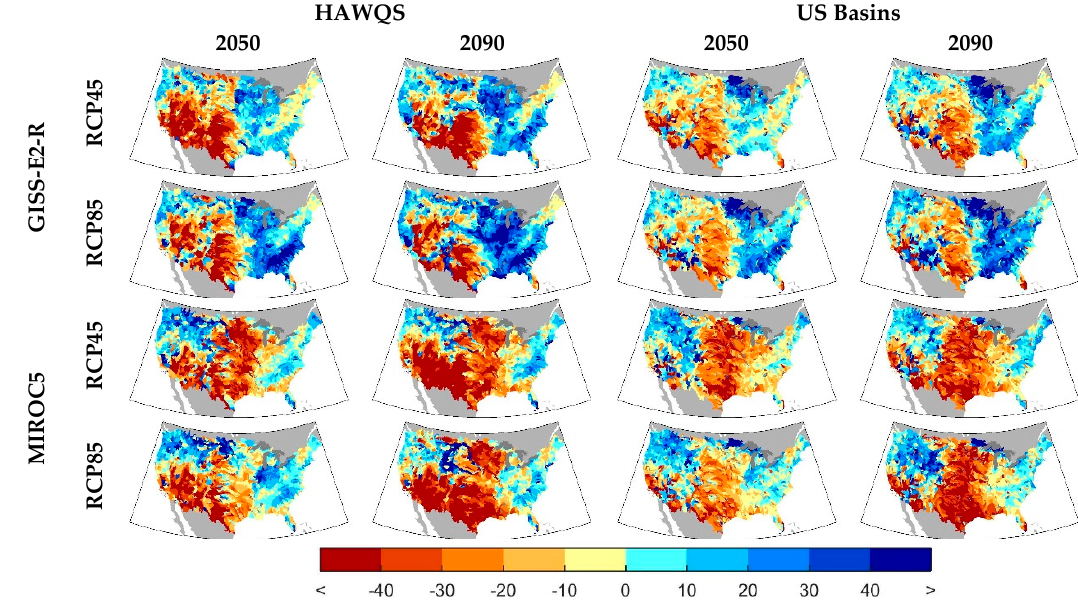
Figure 6. Percentage changes in mean projected ( left ) HAWQS and ( right ) US Basins river flow at the HUC-8 watershed scale for both the GISS-E2-R and MIROC5 climate models, two emissions scenarios, and two eras.